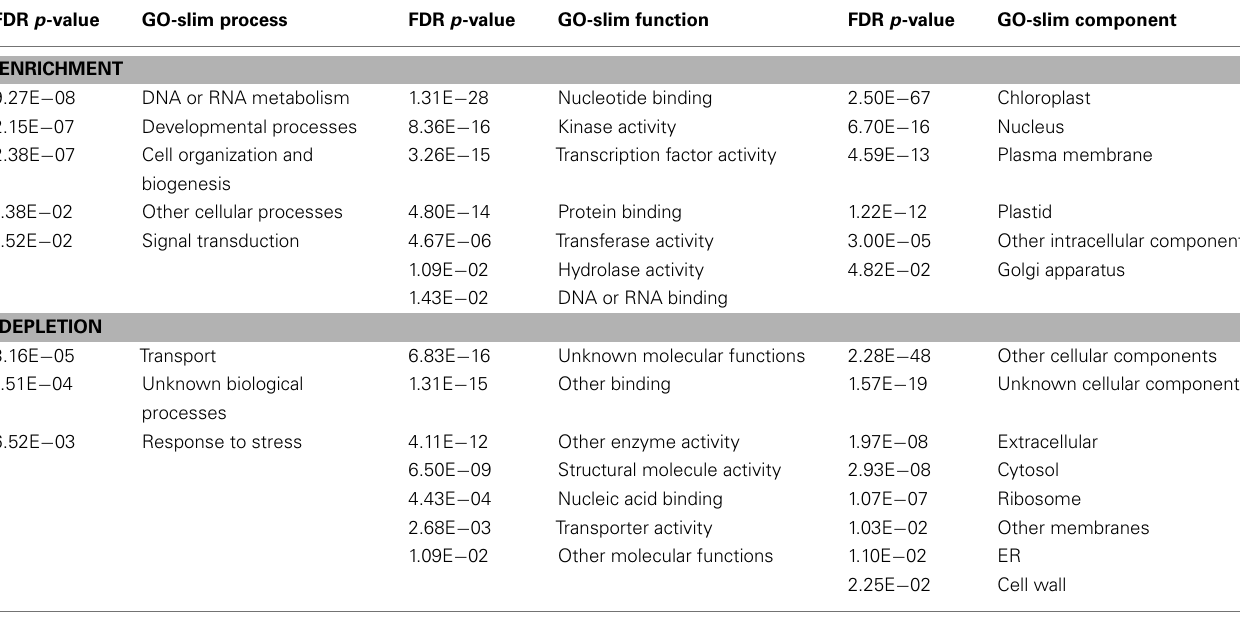
Table 4 | Gene ontology-slim terms statistically enriched or depleted in the set of 9,599 Arabidopsis proteins (corresponding to 7,847 genes) predicted to contain P-hotspots based on SVM scores >